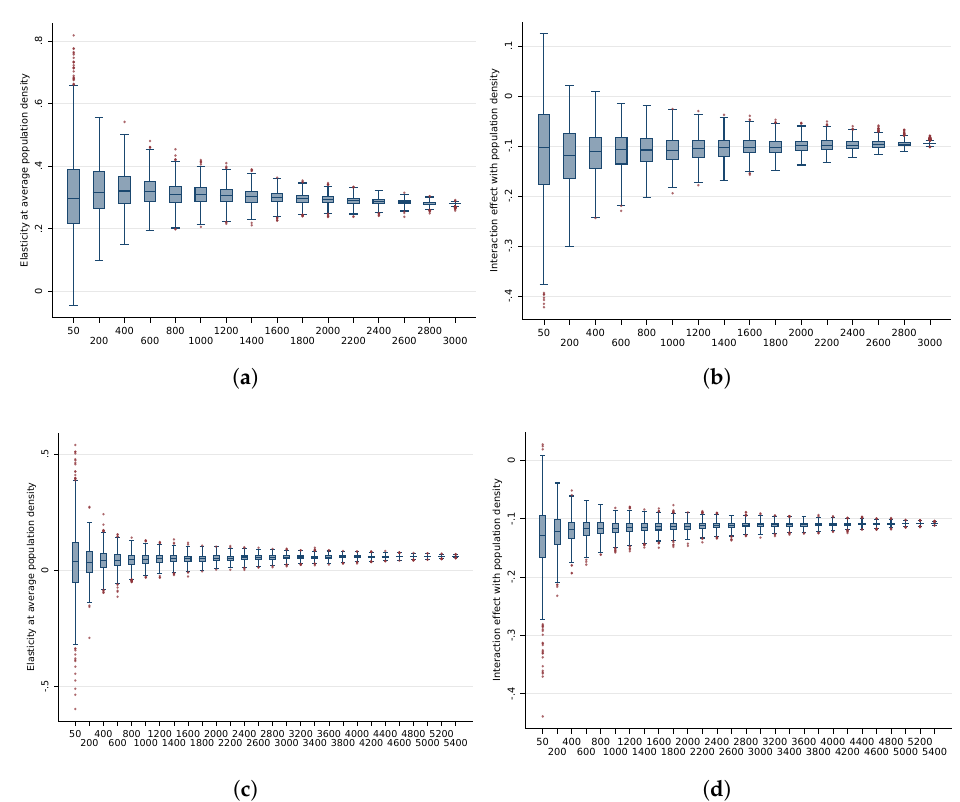
Figure 6. Distribution of estimates across partition simulations, by number of units. ( a ) USA: Elasticity at average ( ˆ β ), ( b ) USA: Interaction ( ˆ γ ), ( c ) Brazil: Elasticity at average ( ˆ β ), ( d ) Brazil: Interaction ( ˆ γ